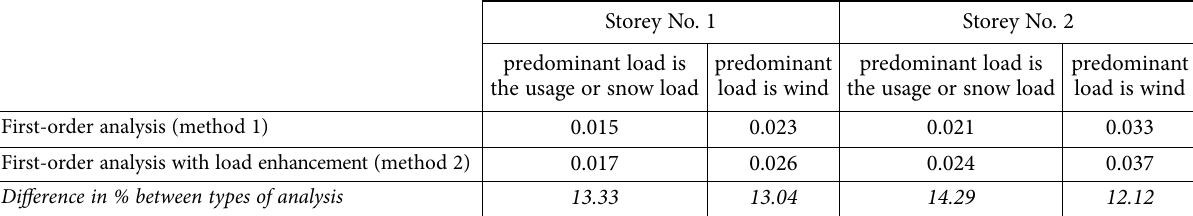
Table 2. Results of frame deformations calculated by methods 1 and 2 Storey No. 1